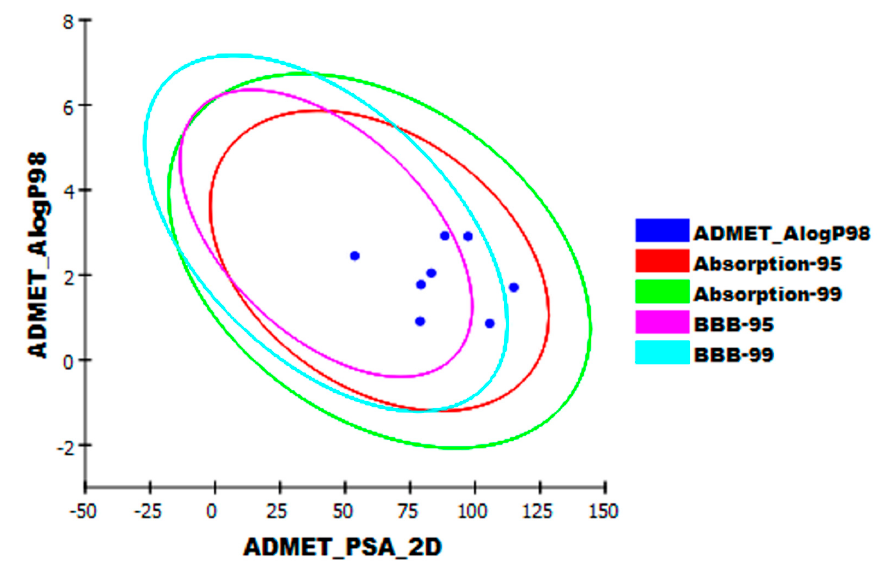
Figure 16. The expected ADMET study.